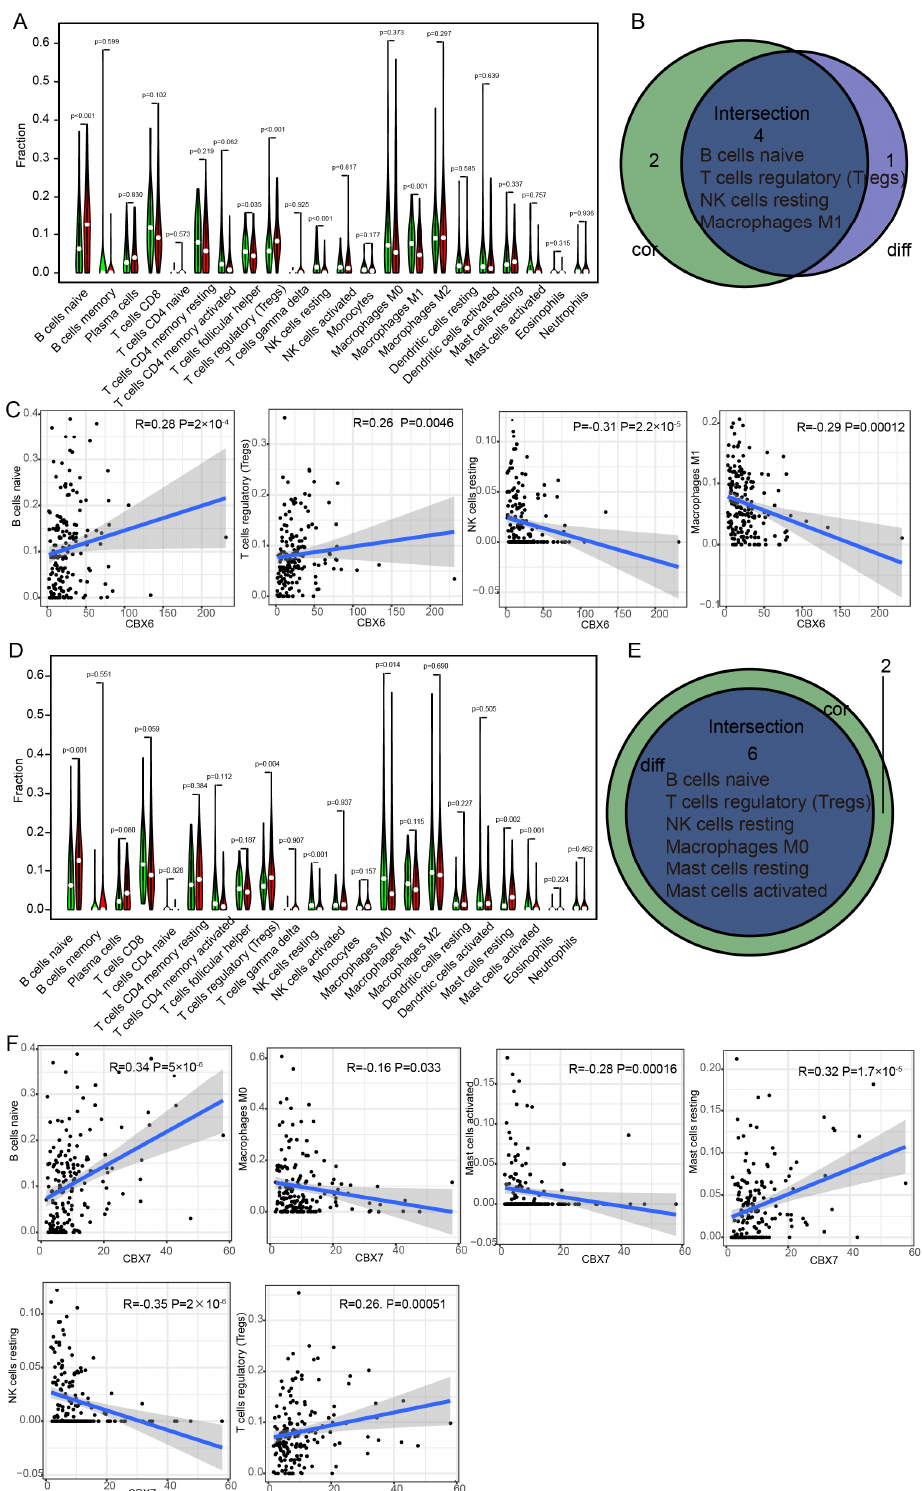
Figure 10. The correlation between CBX6/CBX7 and immune cells. ( A , D ) The differential expression of immune cell types in the CBX6 ( A ) and CBX7 ( D ) high- and low-expression groups. ( B , E ) Overlap between the correlation and differential analyses of CBX6 and CBX7. ( C , F ) Correlation analysis of the expression of CBX6 and CBX7 and the levels of different immune